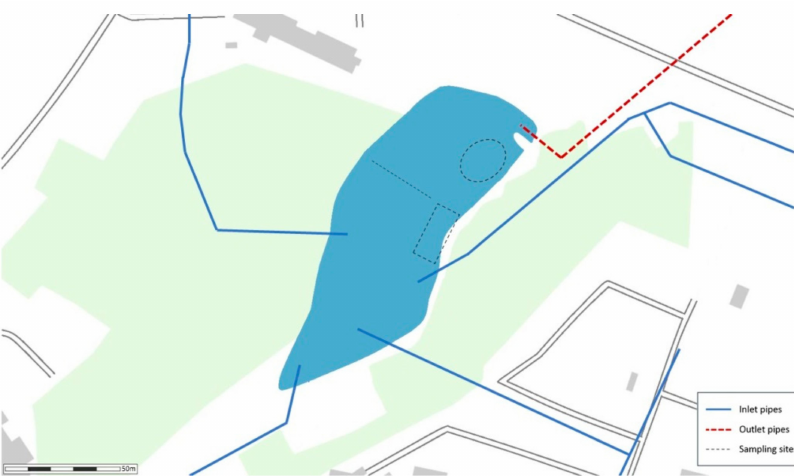
Figure 1. The sampled pond, its catchment, and the locations at which samples were collected. The sediments were sampled in the area marked with a dotted square, the water was sampled in the area marked with a dotted circle, and the fish were caught in the area marked with a dotted line. The blue lines show the inlets where stormwater is discharged into the pond and the red dotted line shows the outlet pipe of the